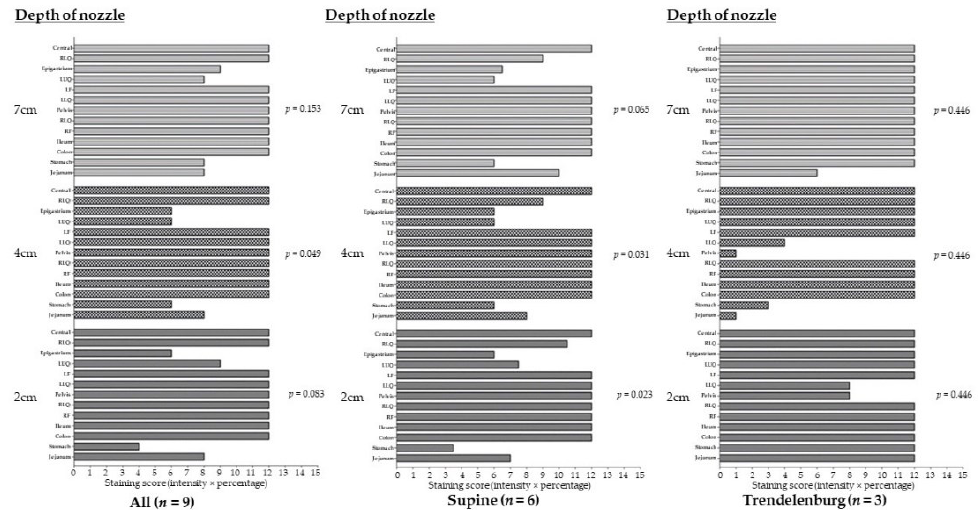
When we evaluated the distribution among 13 regions, scores were not different in the 2, 4, and 7 cm depth of the nozzle. In six pigs with the supine position, scores were not different in 2 and 7 cm depth, whereas uneven distribution was shown in the 4 cm depth of the nozzle. On the other hand, the distribution was not different among 13 regions in 2, 4, and 7 cm depth of the nozzle for three pigs with the Trendelenburg position (Figure 2).